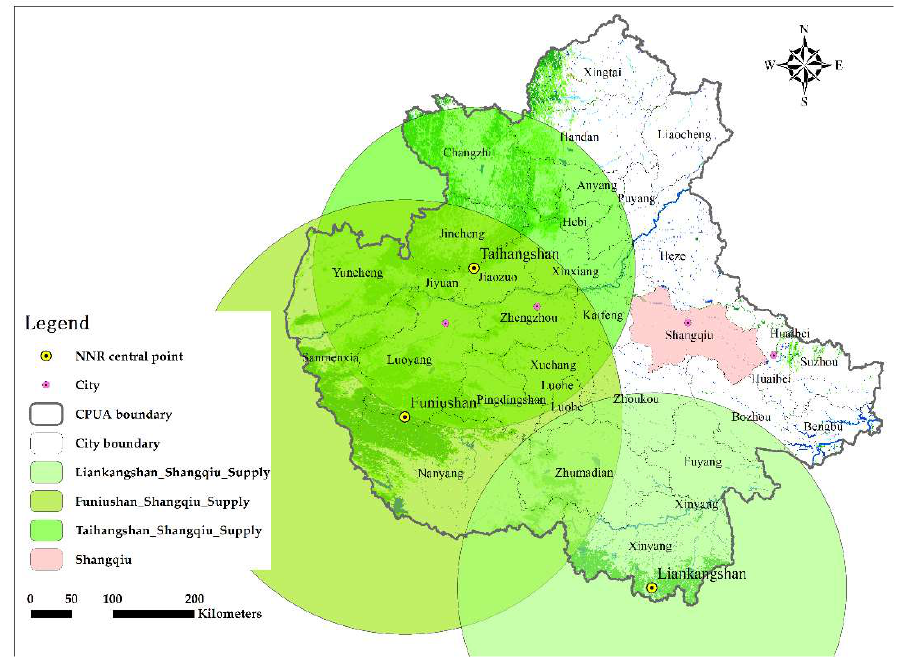
Figure 9. Integrated ES supplies of ecospace ES to Shangqiu.